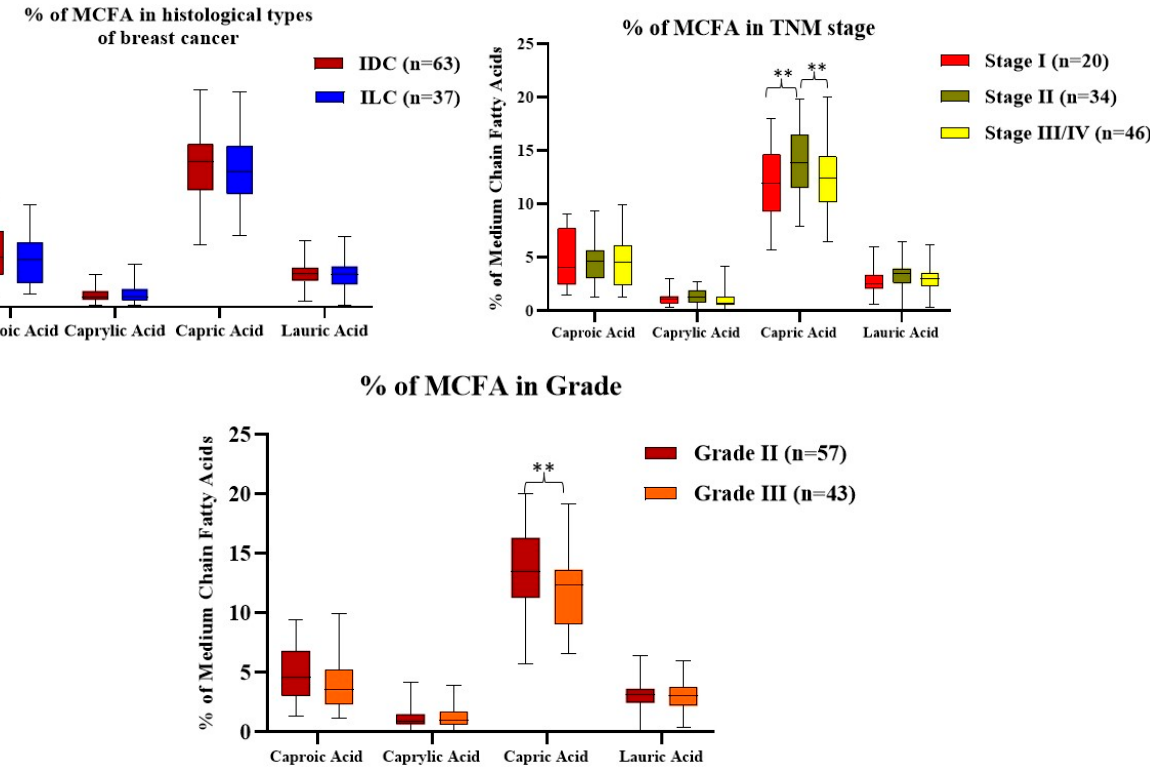
Figure 2. Comparison of MCFA levels in terms of histological types, TNM stage, and grades of breast cancer subjects. The amount of each MCFA was calculated as a % of total MCFAs. p -value was calculated using the Mann–Whitney U test for non-parametric variables. Data are shown as median (interquartile range). ** p < 0.001. Abbreviations: TNM—Tumor Node Metastases; Tumor IDC—Invasive ductal carcinoma; ILC—Invasive lobular carcinoma; MCFA—Medium-chain fatty acid.